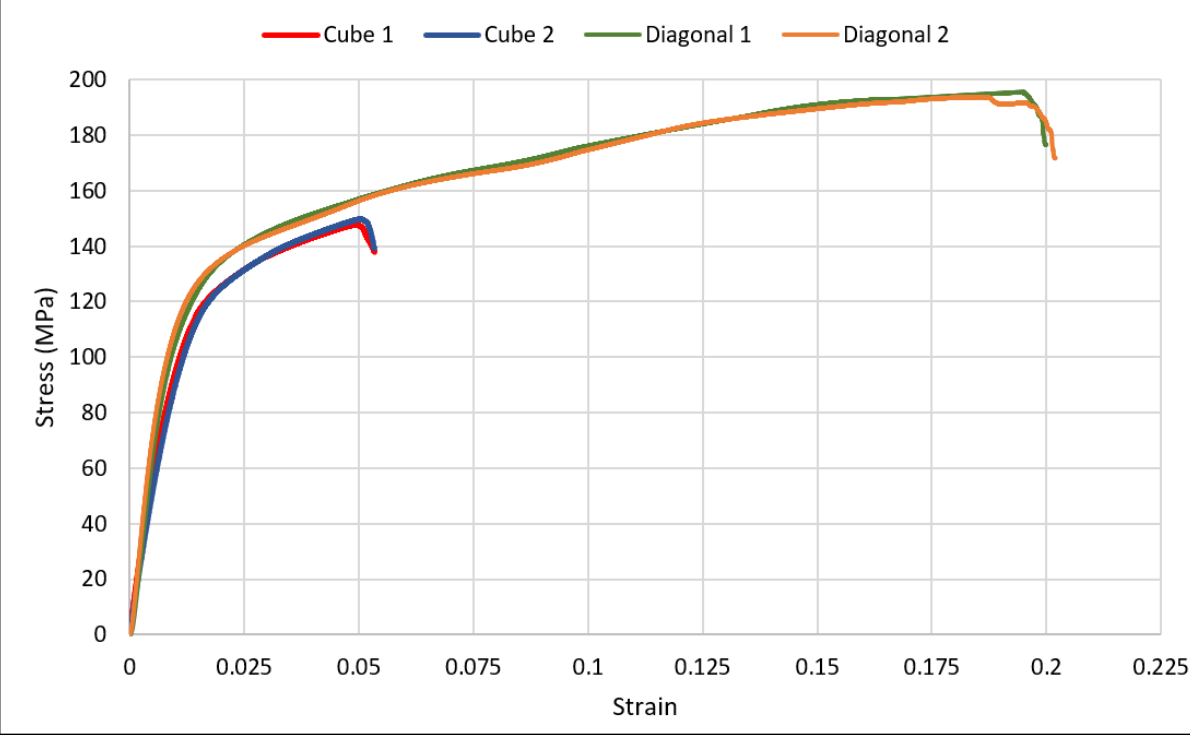
Figure 6. Flexural stress-strain curves for cubic and diagonal scaffolds.